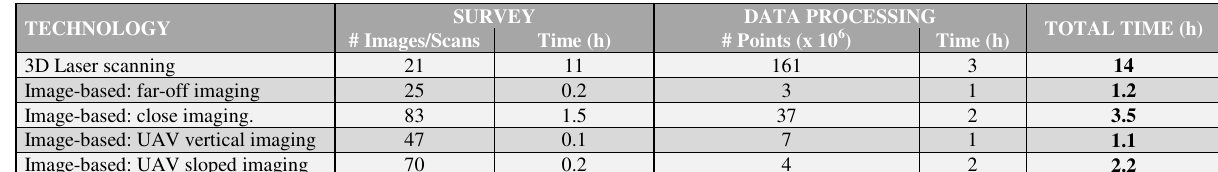
Table 1. 2D/3D data acquisition and processing timing.